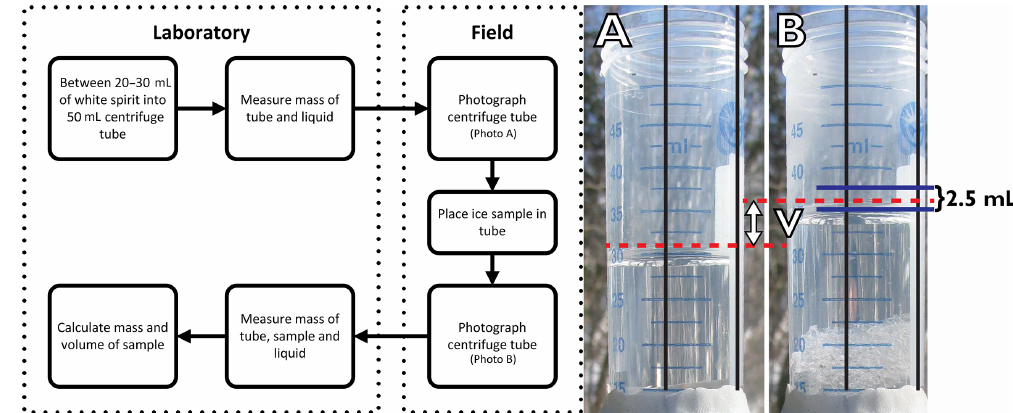
Figure 1. Flow chart describing the methodology to measure densities of ice layers from a snowpack. Photographs show an example pair of photos used in the calculation of ice sample volume. “A” taken before the sample was added and “B” taken after. “V” is equal to the volume of the ice sample. Black lines are guides added to help assess the quality of the